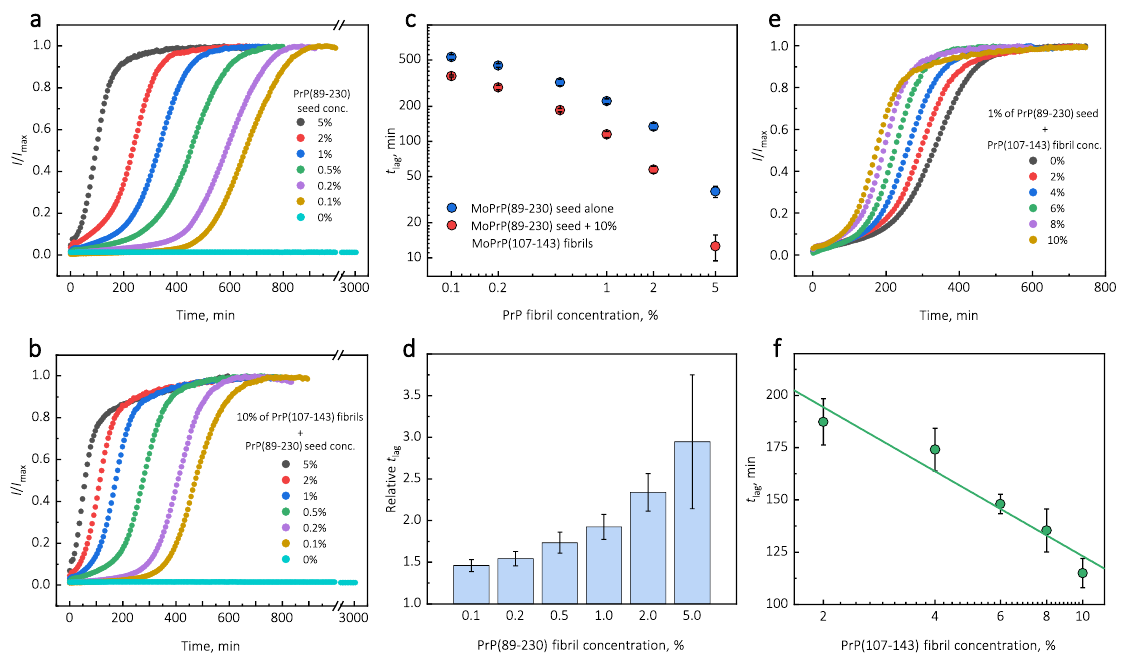
Figure 1. Representative curves of PrP-seed-induced aggregation reaction kinetics performed in the absence ( a ) or presence ( b ) of PrP(107-143) fibrils. Logarithmic plot of t lag values of seed-induced aggregation reaction performed in the absence and presence of 10% of PrP(107-143) fibrils ( c ). Relative t lag values (ratio between t lag in the absence and presence of 10% peptide fibrils) ( d ). Dependence of PrP(89-230)-seed-induced aggregation reaction kinetics on the initial concentration of PrP(107-143) fibrils ( e , f ). Error bars are standard deviations ( n = 9).